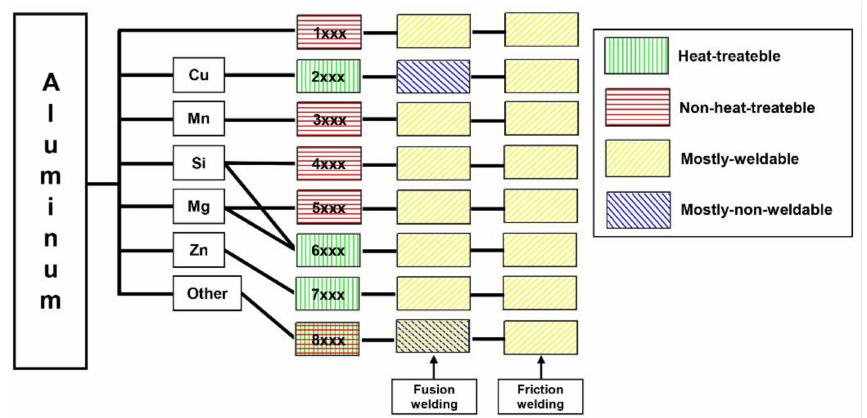
Figure 1. The weldability of aluminum and its alloys